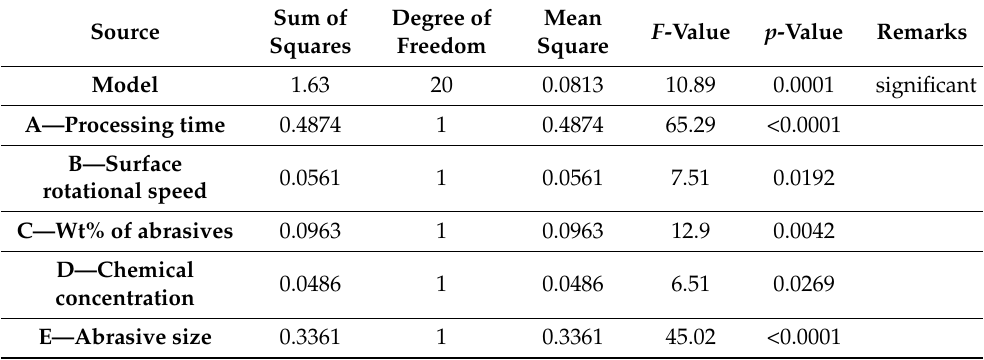
Table 5. ANOVA for